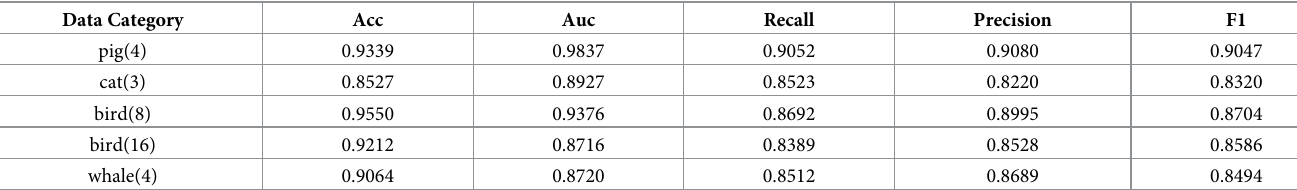
Table 5. On the performance of fusion models tested on different animal sound